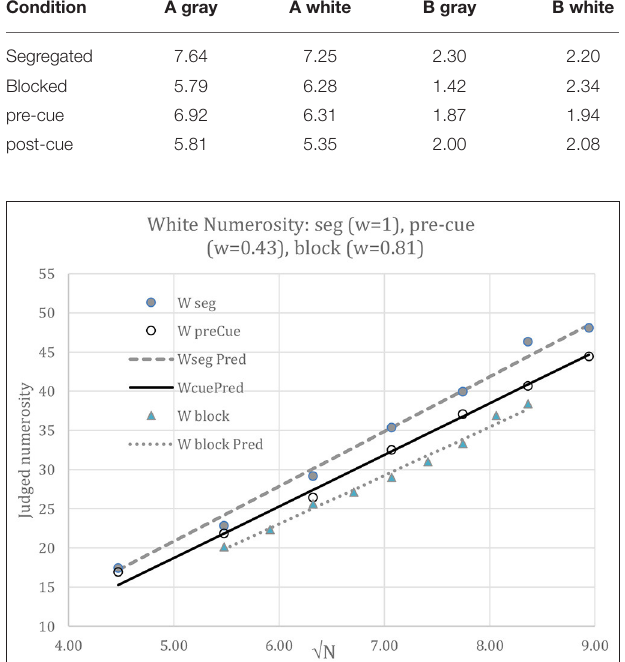
TABLE 2 | Best-fit parameters A, B to segregated or intermingled (blocked or cued) grey and white disk numerosities. Condition